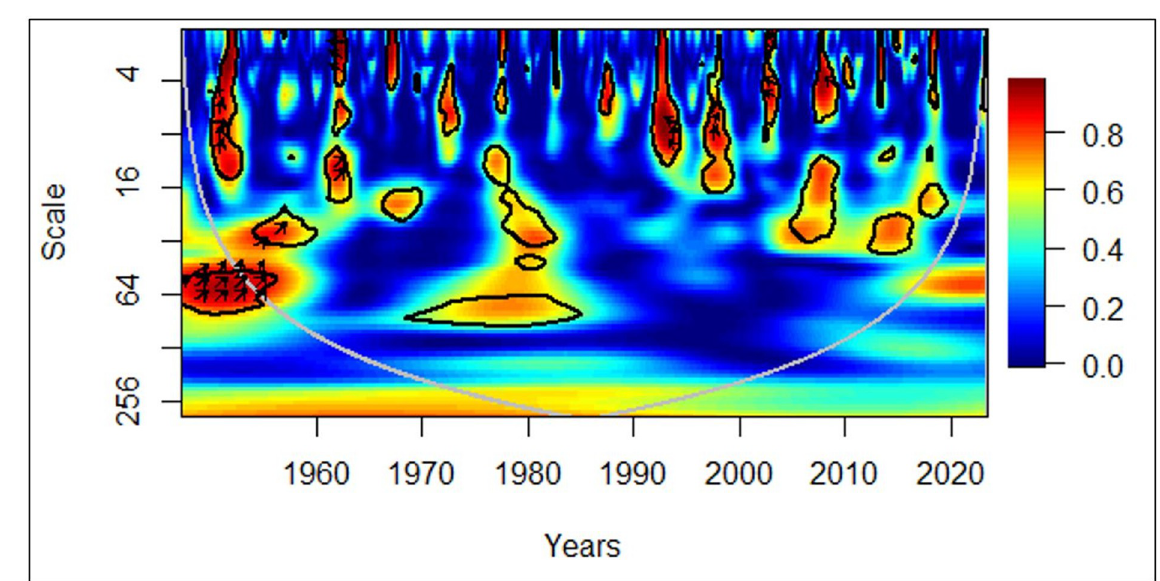
Fig 6. Asian region: GDP vs EPOP. Source: Authors’ illustration.